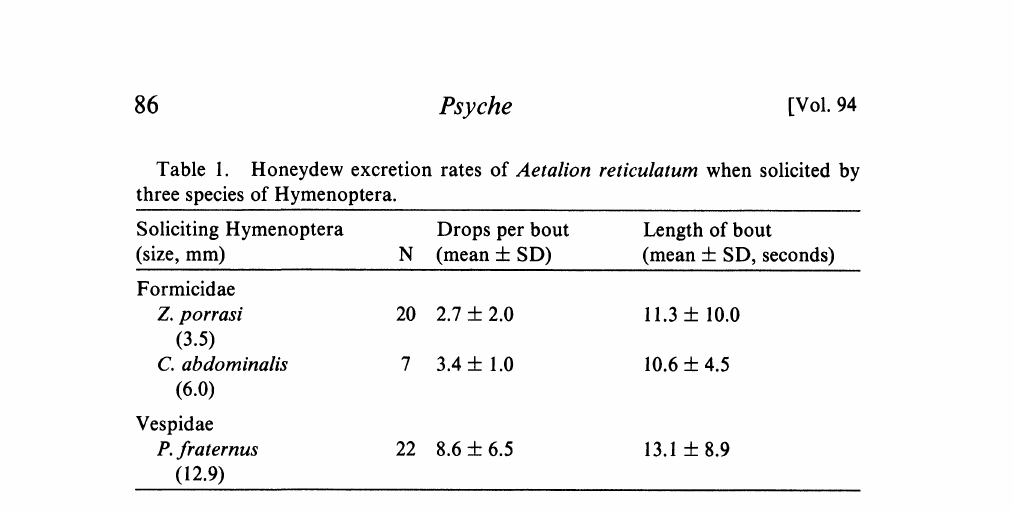
Drops per bout N (mean+ SD)